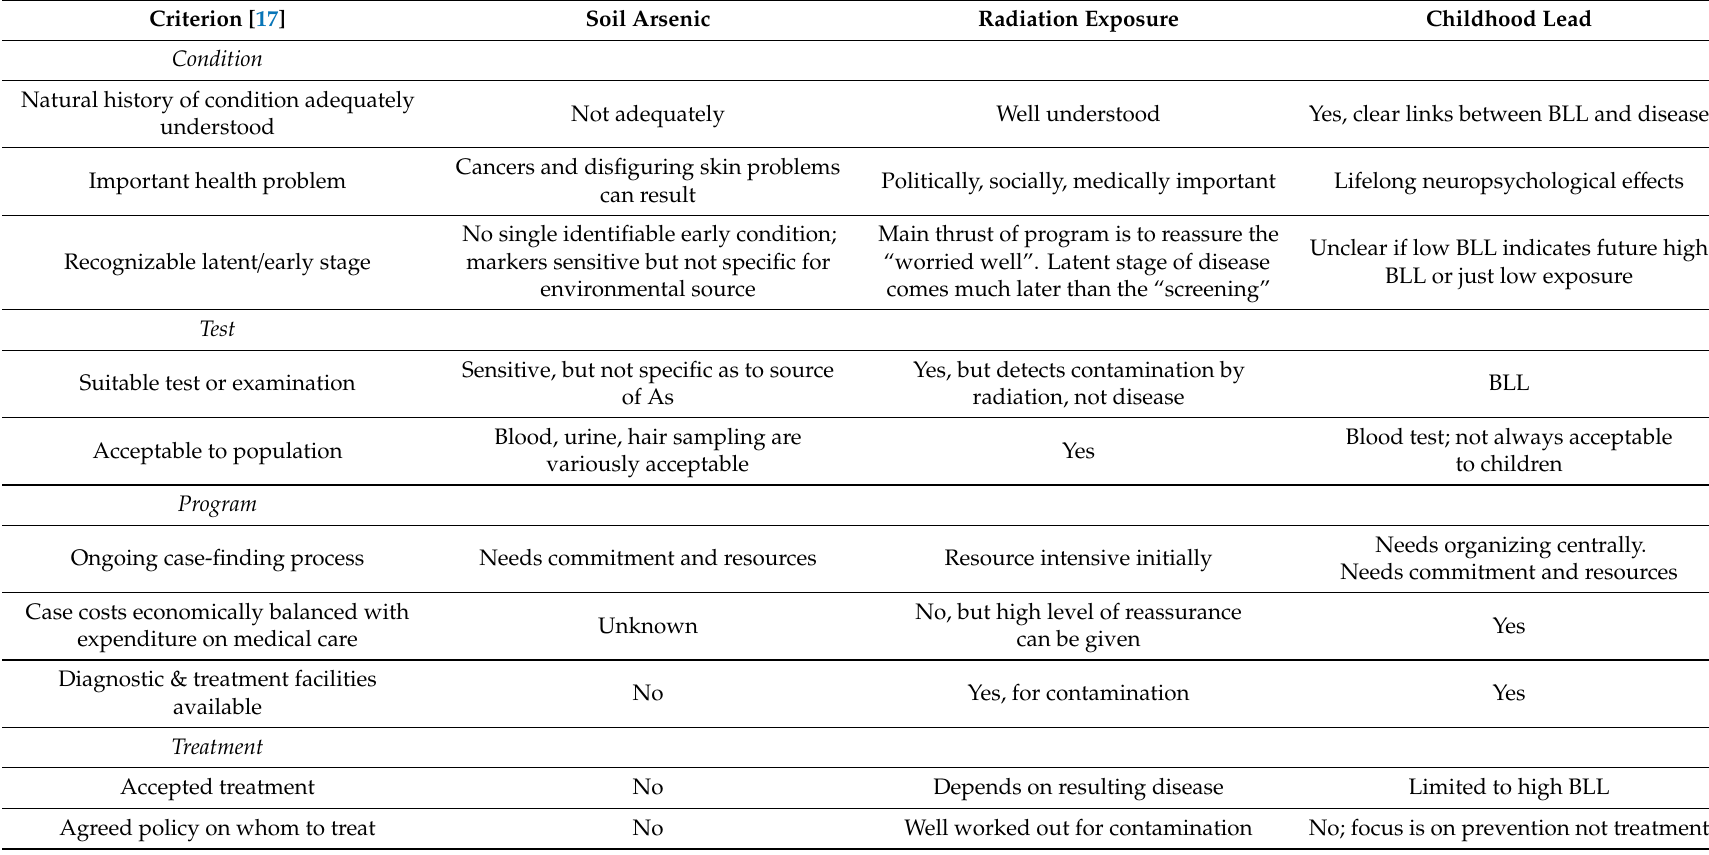
Table 3. Using population screening following environmental contamination: Three worked examples assessed against Wilson and Jungner [17]